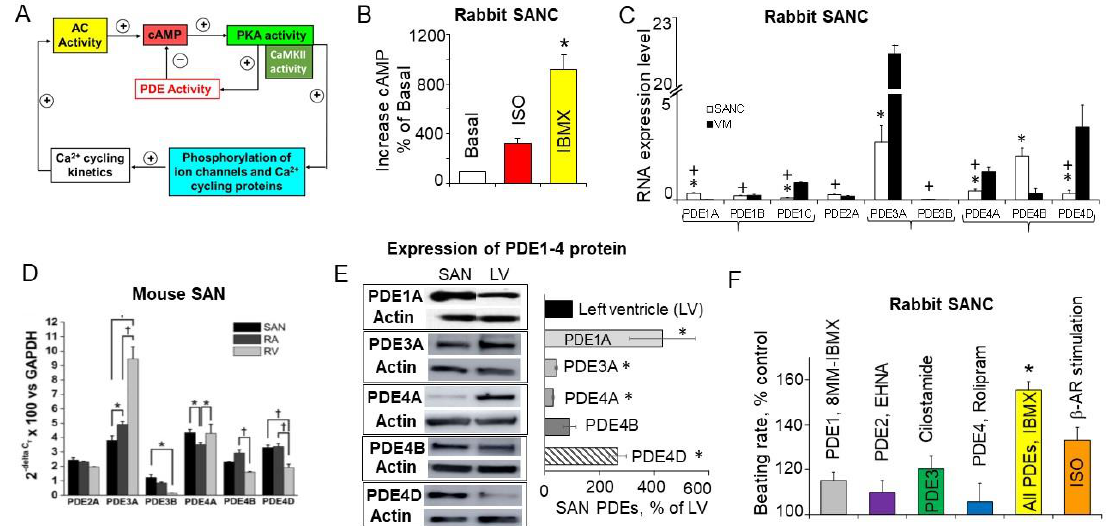
Figure 3. Constitutive basal PDE activation, PDE isoforms, and their role in the regulation of normal cardiac pacemaker function. ( A ) Cartoon of positive basal Ca 2+ /cAMP-PKA “feed-forward” system kept in check by high basal PDE activity, which acts as a negative feedback mechanism restricting cAMP/PKA signaling and preventing an excessive basal beating rate. ( B ) Suppression of PDE activity in SANCs markedly increases the level of cAMP exceeding effect produced by saturating concentration of β -AR agonist isoproterenol (ISO). One-way ANOVA with Bonferroni post hoc test * p <0.01 (IBMX vs. Basal or ISO) (modified from [41]). ( C ) Relative expression of PDE-coding transcripts (mean ± SEM) in rabbit SANCs and ventricular myocytes (VM); (n = 4–9). One-way ANOVA with Tukey post hoc test, adjusted * p < 0.05 (SANC vs. VM for each PDE subtype); + p < 0.05 (PDE subtypes in SANC vs. PDE3A or PDE4B) (from [11]). ( D ) Quantitative mRNA expression of PDE 2, 3, and 4 subtypes in mouse SA node, right atrium (RA), and right ventricle (RV). Expression of PDE2A, PDE3A, PDE3B, PDE4A, PDE4B, and PDE4D are shown relative to GAPDH as (mean ± SEM); n = 5 SA node trials, 5 right atrium (RA) trials, and 3 right ventricle (RV) trials; * p < 0.05; + p < 0.001 by two- way ANOVA with Tukey’s post - hoc test (from [88]). ( E ) (left) Representative western blots of major PDE subtypes in the rabbit SA node and left ventricle, (right) average data (n = 8) of PDE1A, PDE3A, PDE4A, PDE4B, and PDE4D protein expression in the rabbit SA node compared to the left ventricle (LV = 100%), column statistics * p < 0.05 (from [11]). ( F ) Relative increases in the spontaneous SANC beating rate produced by selective inhibitors of cAMP-degrading PDEs (PDE1-PDE4), compared to broad-spectrum PDE inhibitor IBMX or ISO, and expressed as % of control. One-way ANOVA with Tukey post hoc test, * p < 0.05 vs. all PDE inhibition.